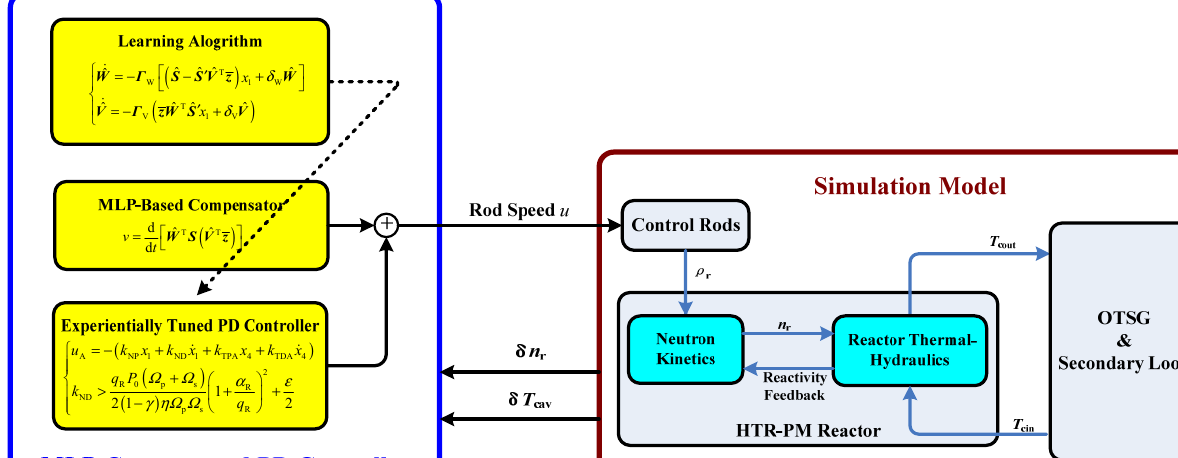
Figure 4. Structure of the closed-loop. MLP: multi-layer perceptron; and PD: